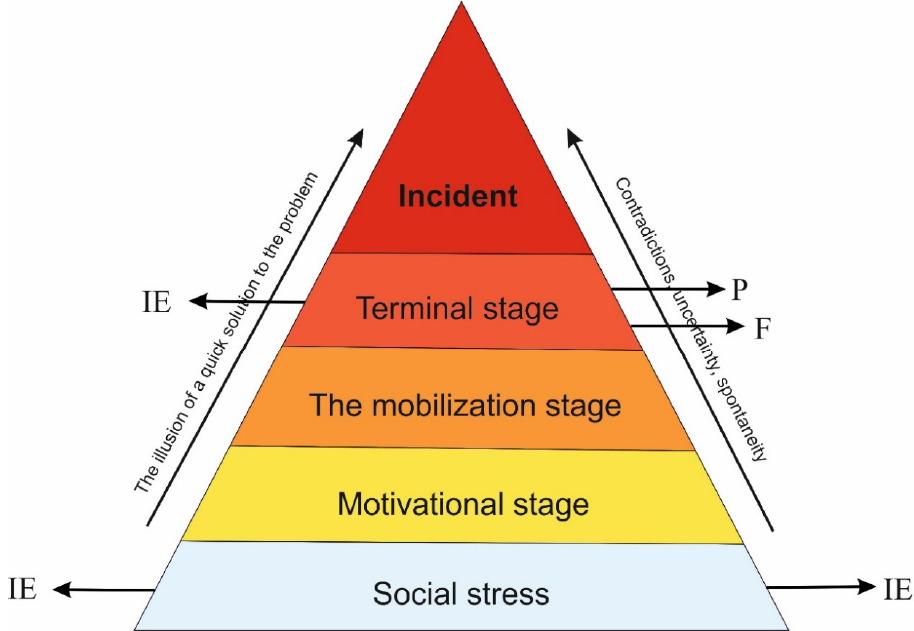
Figure 4. Conceptual model of radicalization of school shooters. IE—Independent Exit. P — Prevention. F —